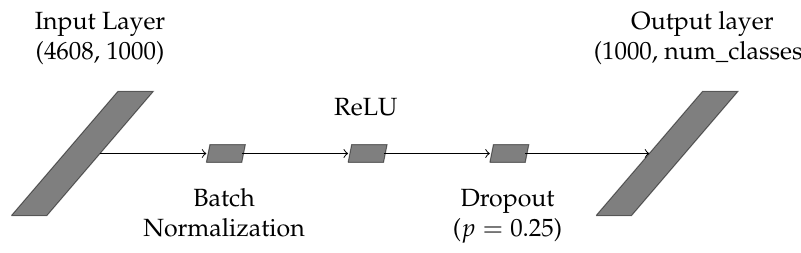
Figure 3. Proposed FCNN